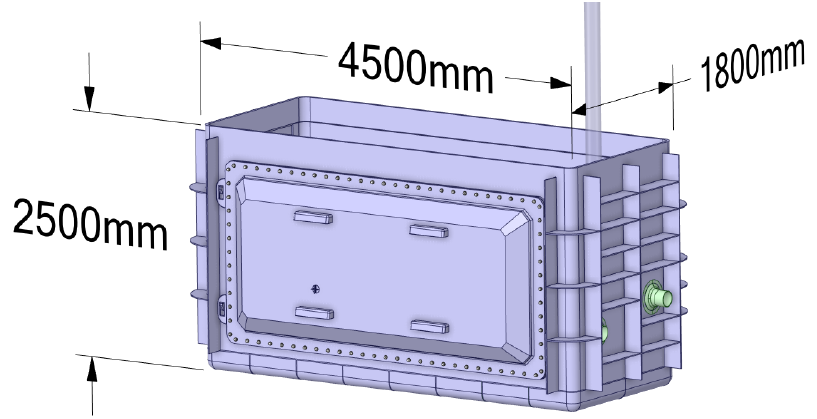
Figure 7. Detailed design model of